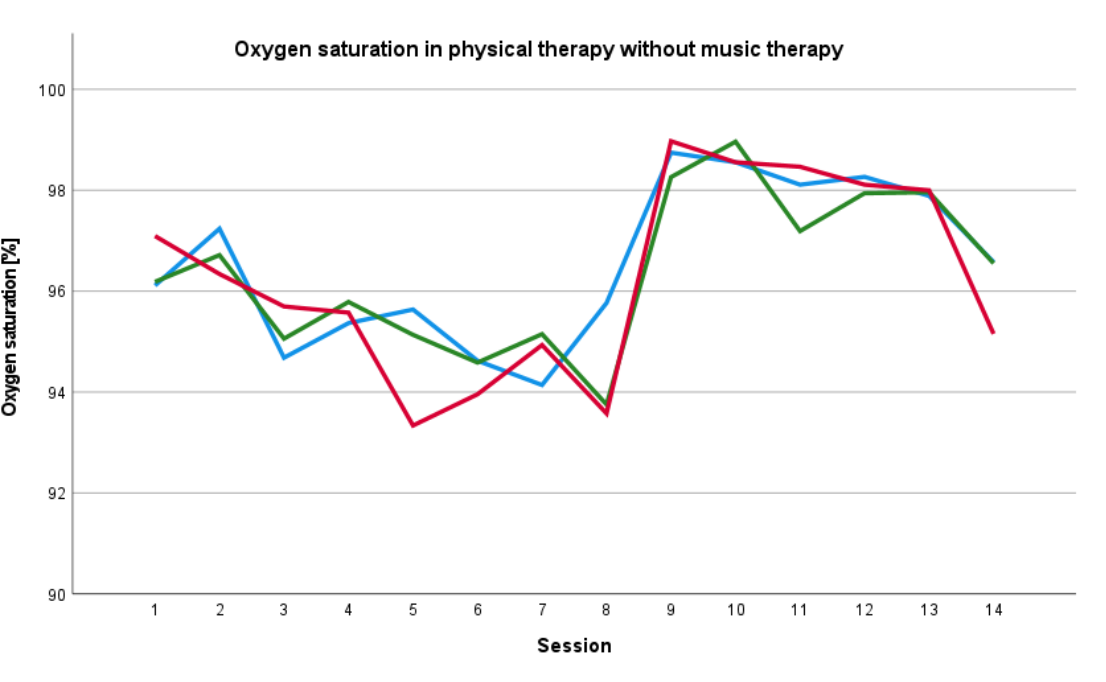
Figure 5. Baseline, peri- and post-therapy oxygen saturation in physical therapy with music therapy. Blue line: mean baseline value, green line: mean peri-therapy value, red line: mean post-therapy value.